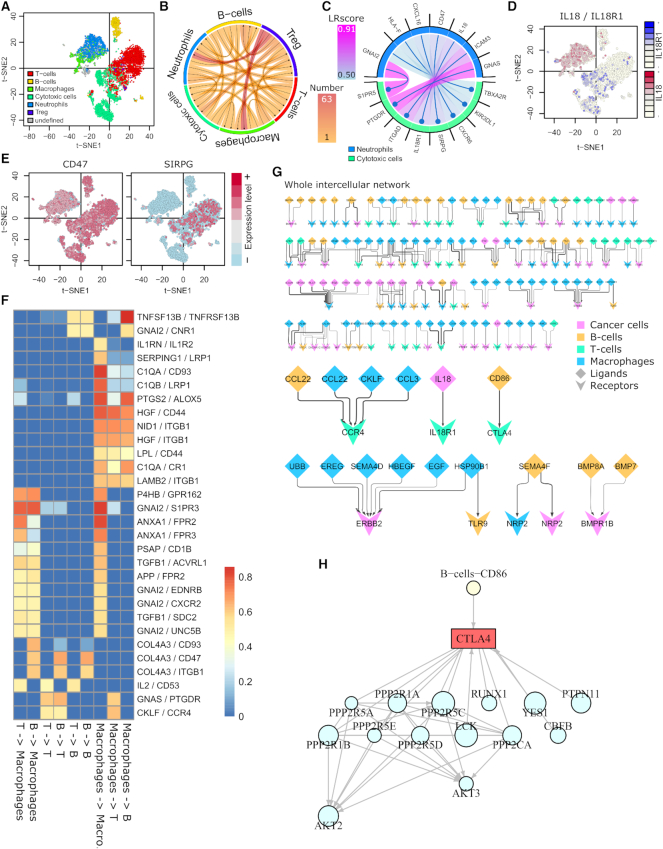
Graphical representations. (A) 10×PBMC data with SIMLR clusters. (B) Summary chord diagram of the paracrine interactions; largest number of interactions from regulatory T cells toward macrophages and neutrophils. (C) Paracrine interactions from neutrophils toward cytotoxic cells. (D andE) Joined, and separated expression plots over the t-SNE map to assess LR interaction specificity and prevalence. (F) Integrated tabular view of the \documentclass[12pt]{minimal}
\usepackage{amsmath}
\usepackage{wasysym}
\usepackage{amsfonts}
\usepackage{amssymb}
\usepackage{amsbsy}
\usepackage{upgreek}
\usepackage{mathrsfs}
\setlength{\oddsidemargin}{-69pt}
\begin{document}
}{}$N$\end{document} most variable LR pairs with LRscore > 0.5 in one cell-type couple at least. (G) Integrated network of MELANOMA data patient 89 intercellular interactions. Overview and chosen interactions. The full network is in Supplementary Figure S13. (H) Example of intracellular signaling downstream CTLA-4 in T cells. Node sizes represent the gene expression level (arbitrary scale).